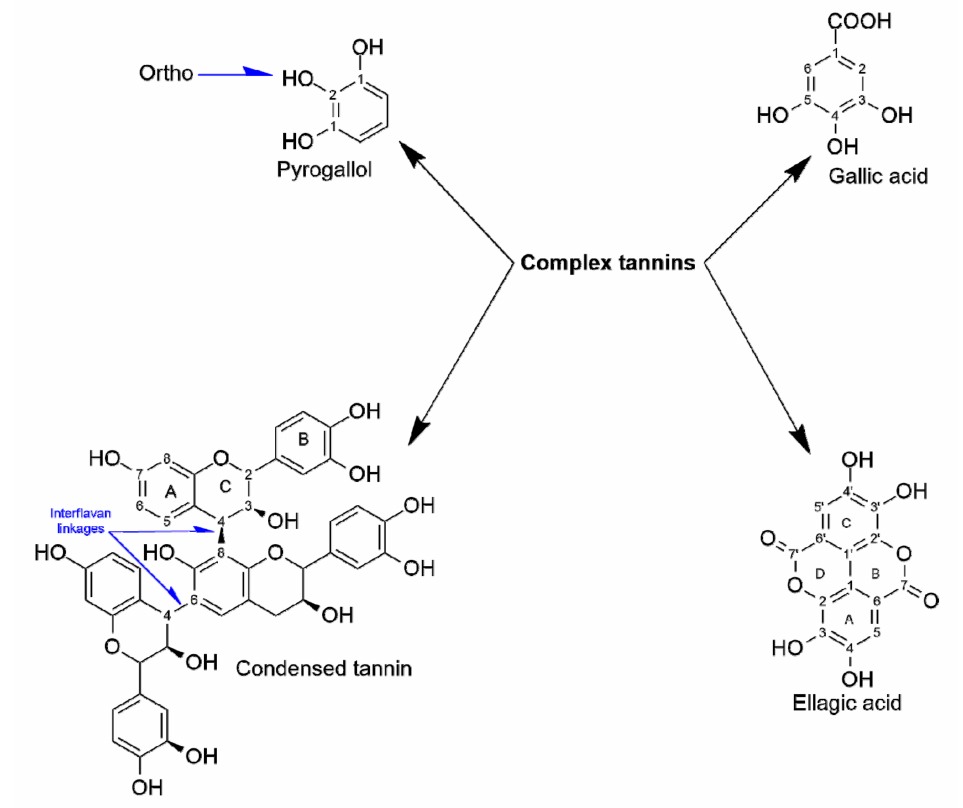
Figure 4. Phenolic structures and salient functional groups that contribute to NFP- and FFP-Miangs’ biological